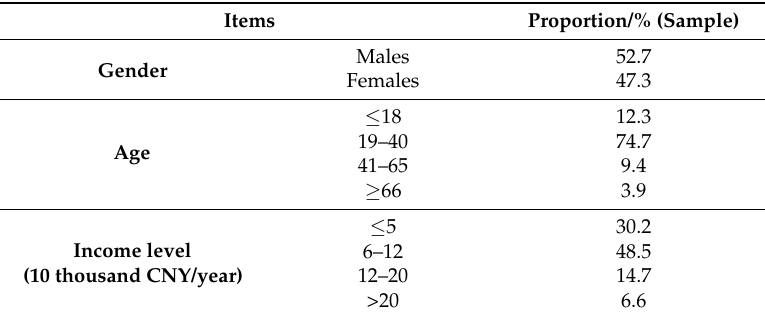
Table 1. Demographic information of the sample.